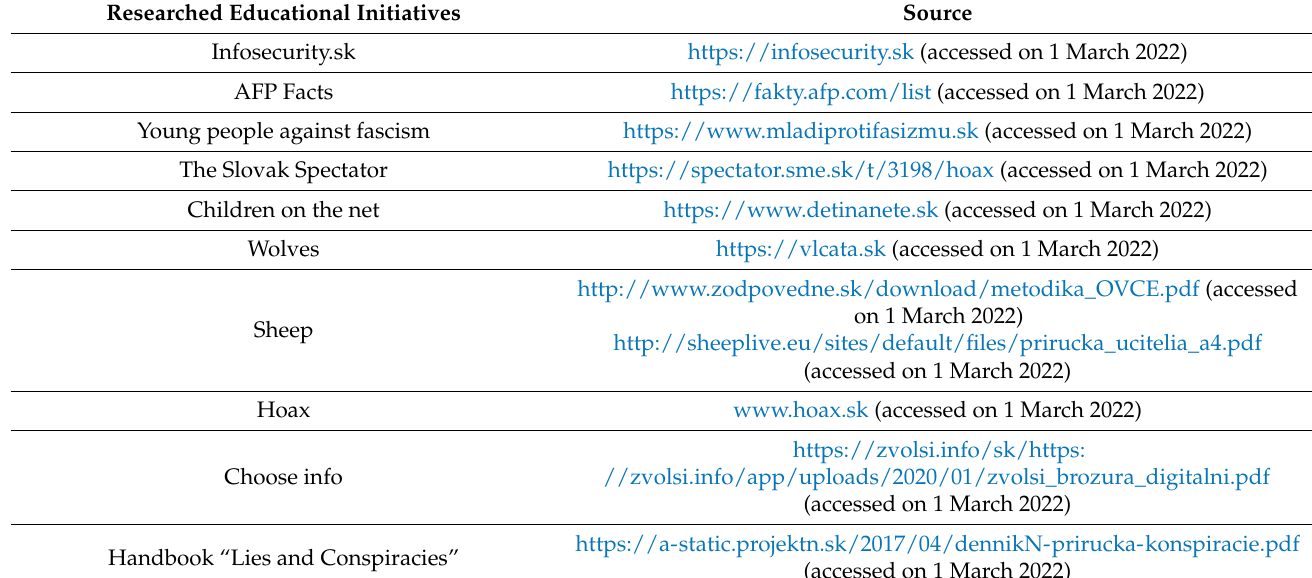
Table 1. Examined educational initiatives focused on the issue of youth education in the context of media manipulation in